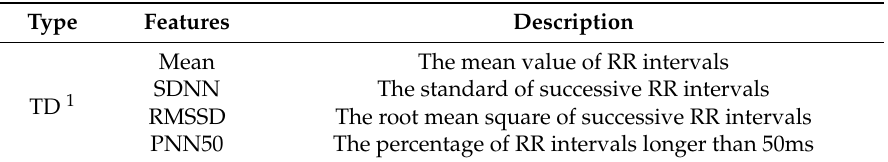
Table 2. List of the extracted features.